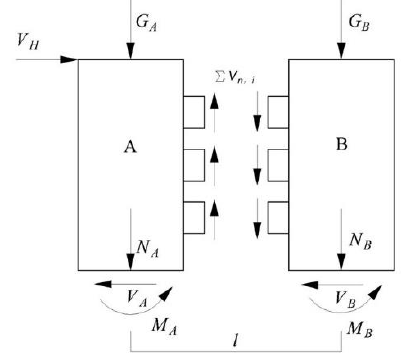
Figure 16. Model of precast shear wall.